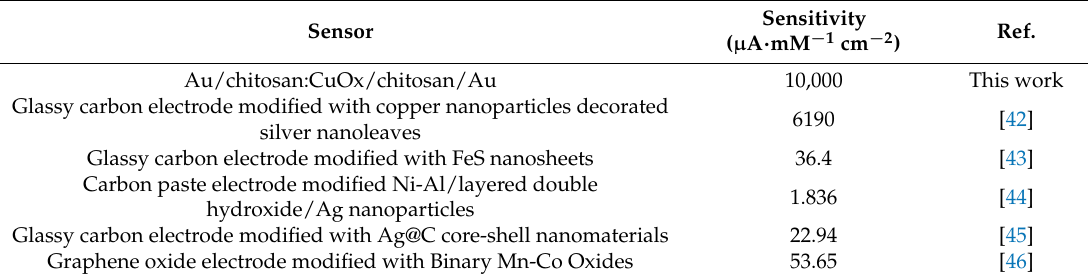
Table 1. Sensitivity of the Au/chitosan:CuOx/chitosan/Au cell towards H 2 O 2 , compared to that of other electrochemical